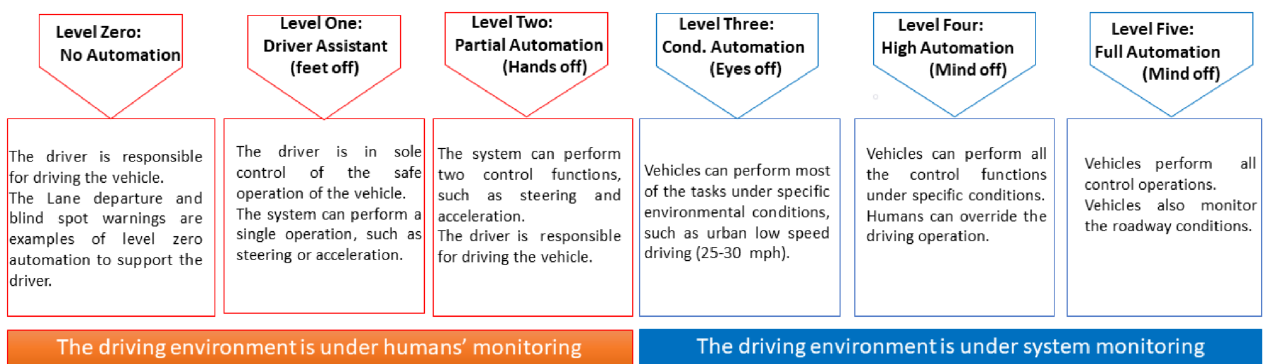
Figure 2. The levels of autonomous driving. In the first three levels (level zero to level two), the humans monitor the driving environment, whereas the system monitors the driving environment for the last three levels of